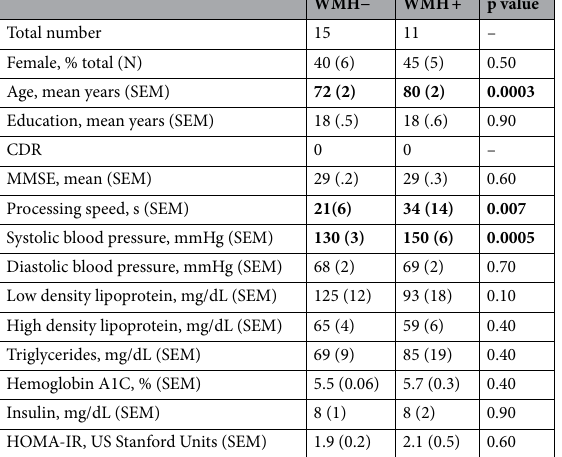
global measure of cognitive function, mini-mental status exam (MMSE), did not significantly differ between groups (p = 0.60). With respect to vascular risk factors, subjects with WMH had on average higher systolic blood pressures (p = 0.0005). No significant difference was noted for diastolic blood pressure (p = 0.70). Diagnosis of hypercholesterolemia (p = 0.90), or hyperglycemia (p = 0.30) did not differ between groups, nor were any signifi- cant differences found in laboratory values for fasting lipid panel (triglycerides p = 0.40; HDL p = 0.40; and LDL p = 0.10), blood insulin concentration (p = 0.90), hemoglobin-A1C (p = 0.40), and the homeostatic model assess- ment of insulin resistance (HOMA-IR) (p = 0.60)—a surrogate for assessing β-cell function. Group differences (Table 2, Fig. 2). Numerical values are summarized in Table 2. Results are consistent with the hypothesis of endothelial inflammatory changes in subjects with WMH. No group differences were noted with respect to EV concentrations or EV size distributions (Supplemental Fig. S2). Levels of EDE comple- ment effector proteins in the classical and alternative pathways were significantly elevated and complement regu- latory proteins were significantly lower in subjects with WMH. After normalizing for EDE concentrations, we found the following factors to have significantly higher levels in subjects with WMH with large effect sizes: C1q (p = 0.002), C3b (p < 0.0001), Factor B (p < 0.0001), Bb (p < 0.0001), and C5b-9 (p = 0.0002). EDE levels of the complement regulatory proteins Factor I (p = 0.02), and CD59 (p < 0.0001) were significantly lower in subjects with WMH. Results remained significant when adjusting for age in a regression model. The following comple- ment factors and regulatory proteins did not reach statistical significance between groups: Factor D (p = 0.40), C4b (p = 0.60), CR1 (p = 0.60), DAF (p = 0.10), CD46 (p = 0.90), and lectin pathway MBL (p = 0.50). Individual markers had AUC values ranging 0.74 to 0.99 (Table 2). The greatest group effect sizes were found for C3b, Bb and CD59. For these EDE complement proteins, the likelihood ratio of having significant WMH in comparison to none or mild WMH was found to be 13.64 at sensitivity of 91% (95% CI 59–100) and specificity of 93% (95% CI 68–100). The associated optimal diagnostic accuracy cut off was > 4.7 ng/mL for C3b, > 28.609 ng/ mL for Bb, and < 0.225 ng/mL for CD59.